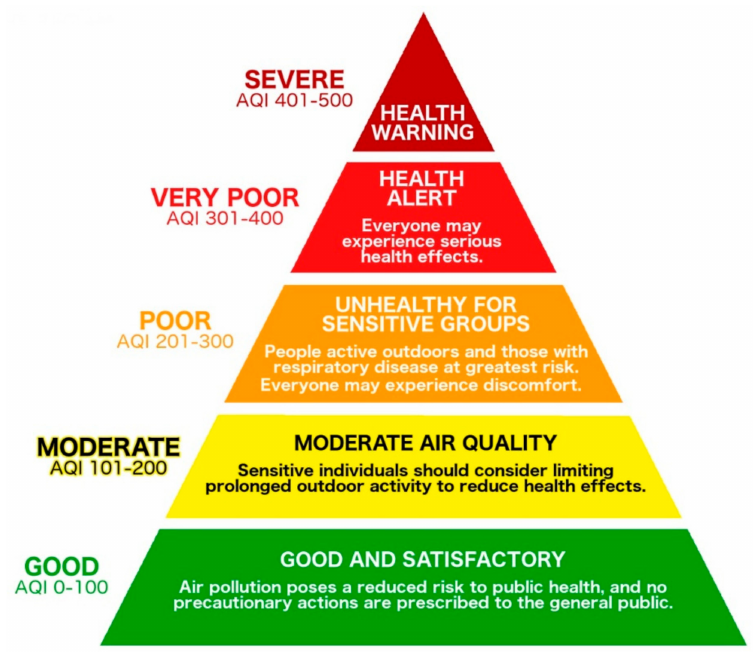
Figure 2. IITM-SAFAR AQI air quality descriptors, index value ranges, and associated health messages [64]. AQI levels 301–400 activate a Health Alert in Ahmedabad, while levels 401–500 activate a city-wide Health